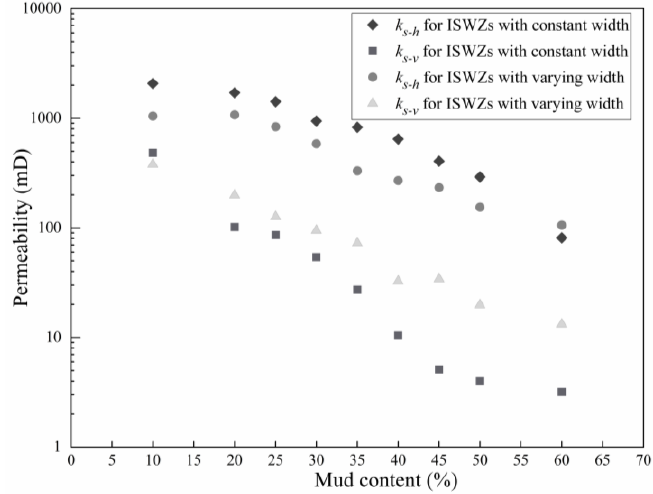
Figure 15. k s calculation results for all eighteen ISWZs.